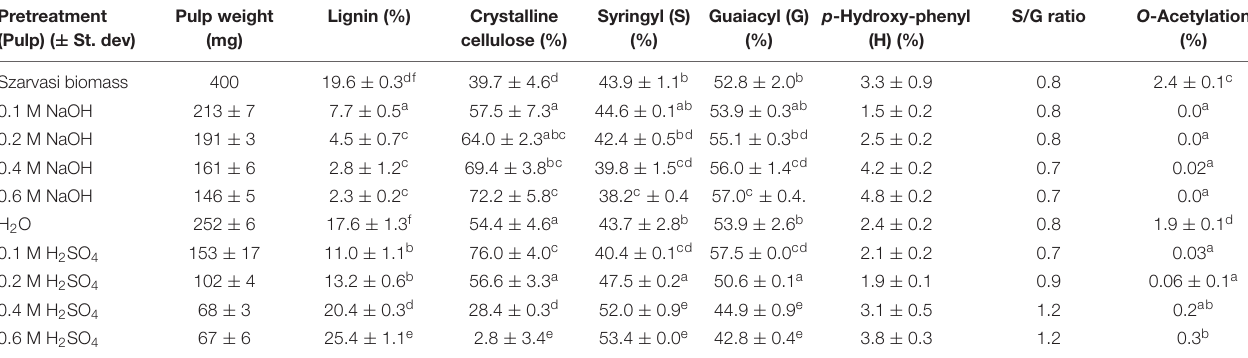
TABLE 1 | Characterization of szarvasi biomass and pulps after various microwave treatments including alkaline (NaOH), neutral (H 2 O), or acidic pretreatments (H 2 SO 4 ). Pretreatment (Pulp) ( ± St.